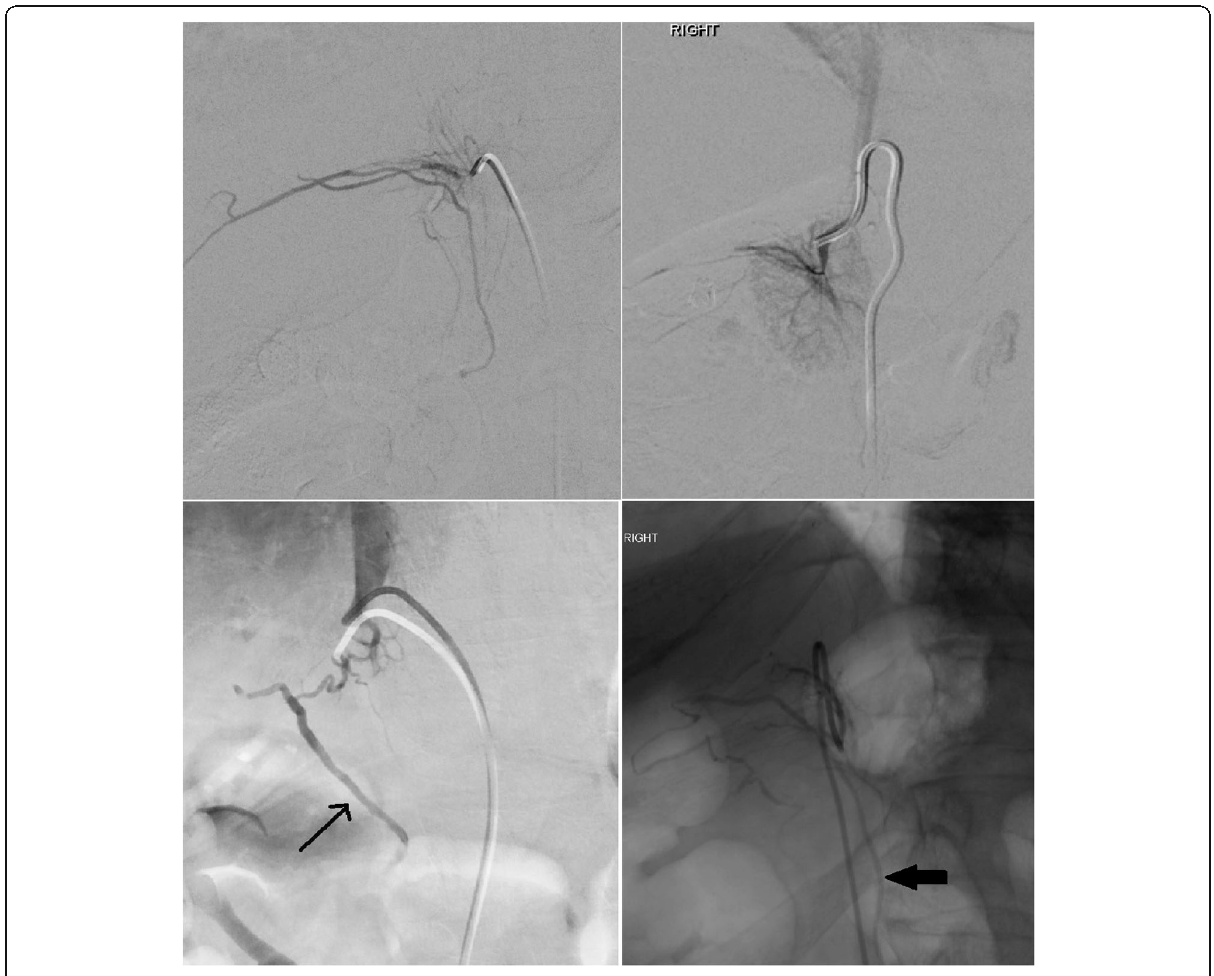
Fig. 1 Varied appearance of the right adrenal vein in 4 different patients. All 4 images are of the right adrenal vein, confirmed by elevated cortisol levels. Images c and d show an inferior emissary vein (black arrows), diagnostic of adrenal vein